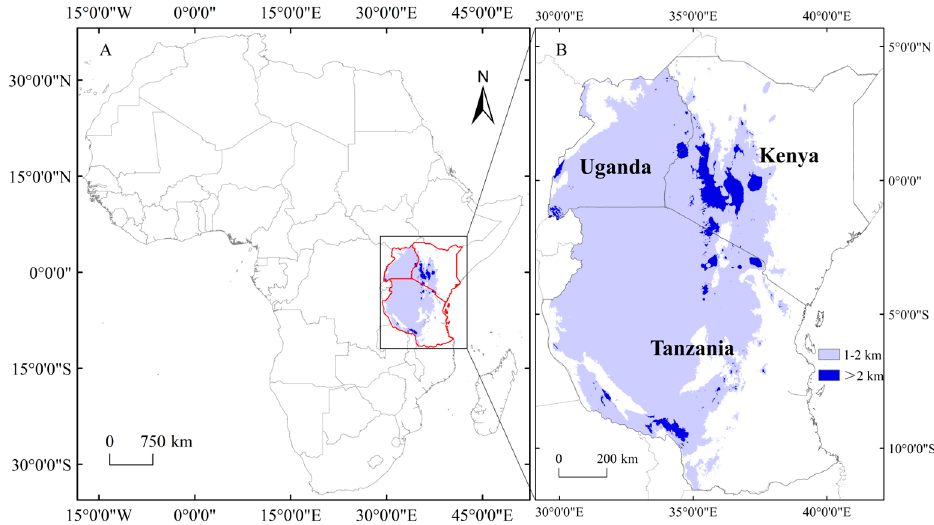
Figure 4. Map of tropical East Africa. ( A ) Geographical location of tropical East Africa; ( B ) National composition. The light blue and blue areas on the map indicate high-altitude areas.